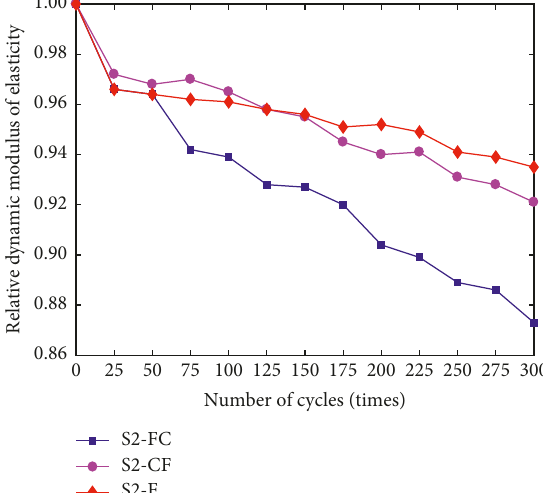
Figure 2: Relative dynamic modulus of elasticity of S2 in different testing